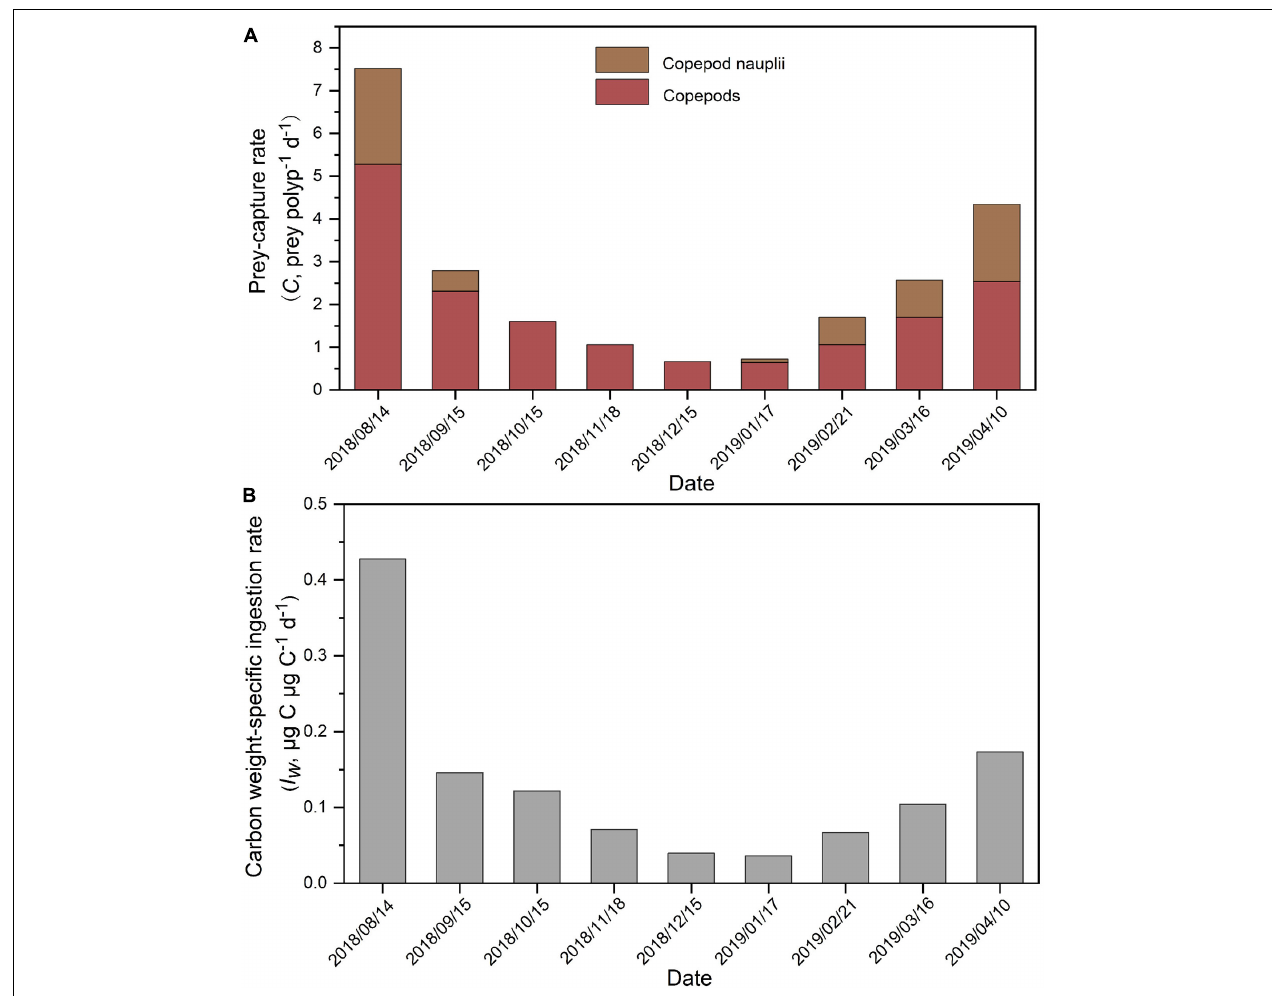
FIGURE 10 | Prey-capture rate ( C , prey polyp − 1 d − 1 ) of copepods and copepod nauplii (A) and seasonal variation in carbon weight-specific ingestion rates for A. coerulea polyps ( I w , µ g C µ g C − 1 d − 1 ; (B) ) during August 2018 to April 2019.